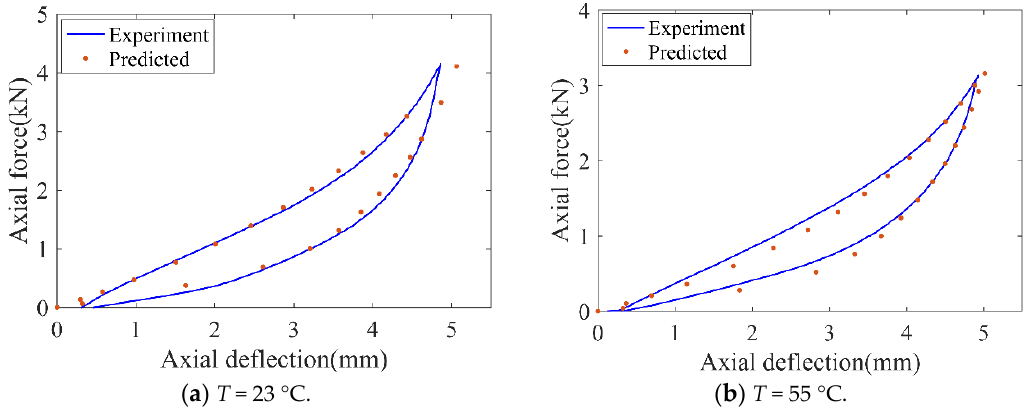
Figure 9. Comparison of load-deflection curves between the simulation and the experiment.